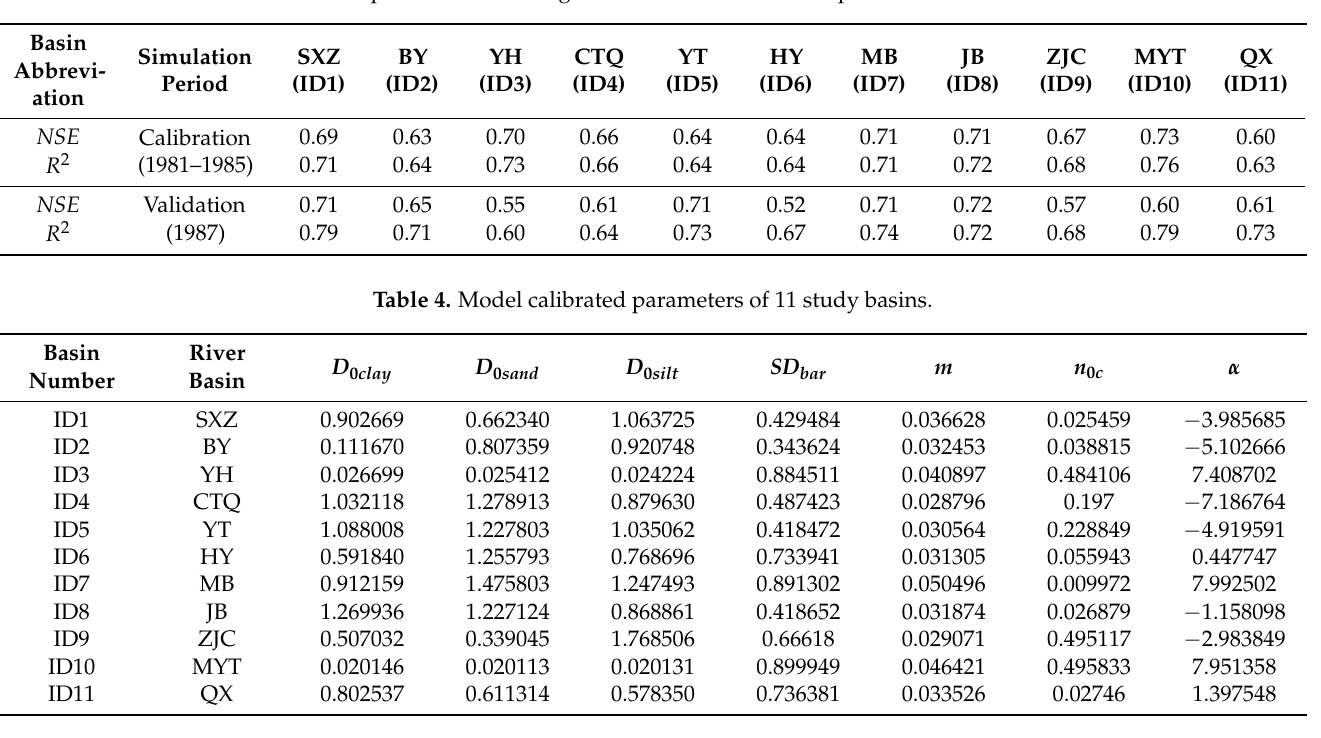
Table 3. Model performance during calibration and validation period of research basins.